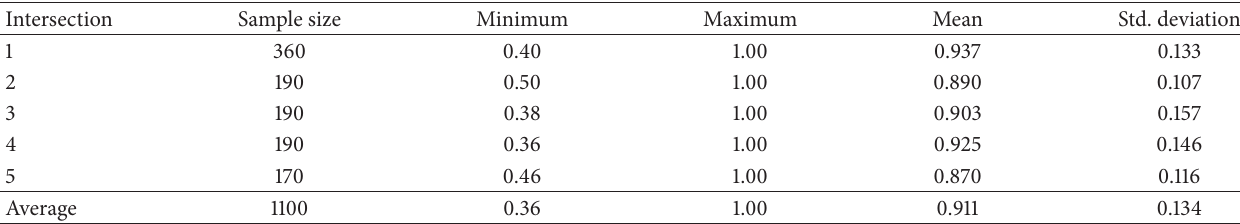
Table 6: Adjustment of variable lane saturation flow rate for the unequal distribution of